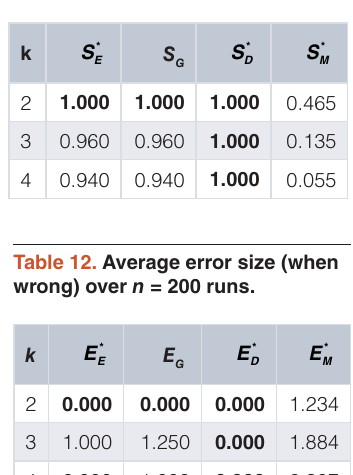
Table 11. Success rate over n = 200 runs.